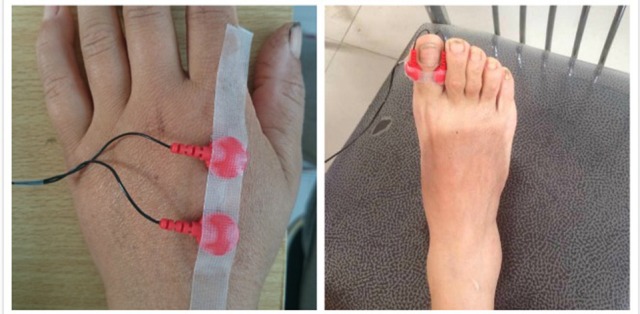
Testing site and the placement of the electrode.